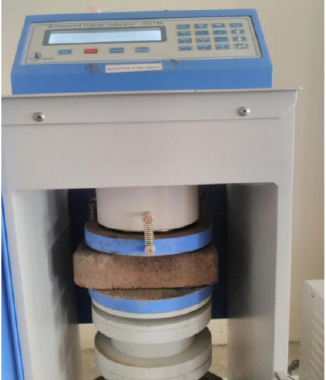
Figure 4. Compressive strength testing of samples.